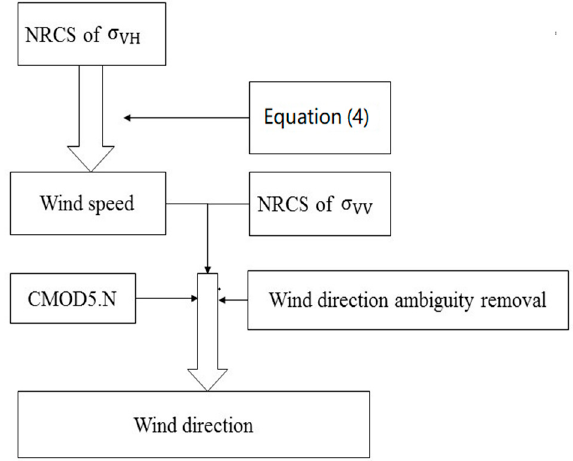
Figure 1. Flowchart for the wind speed and direction retrieval algorithm.